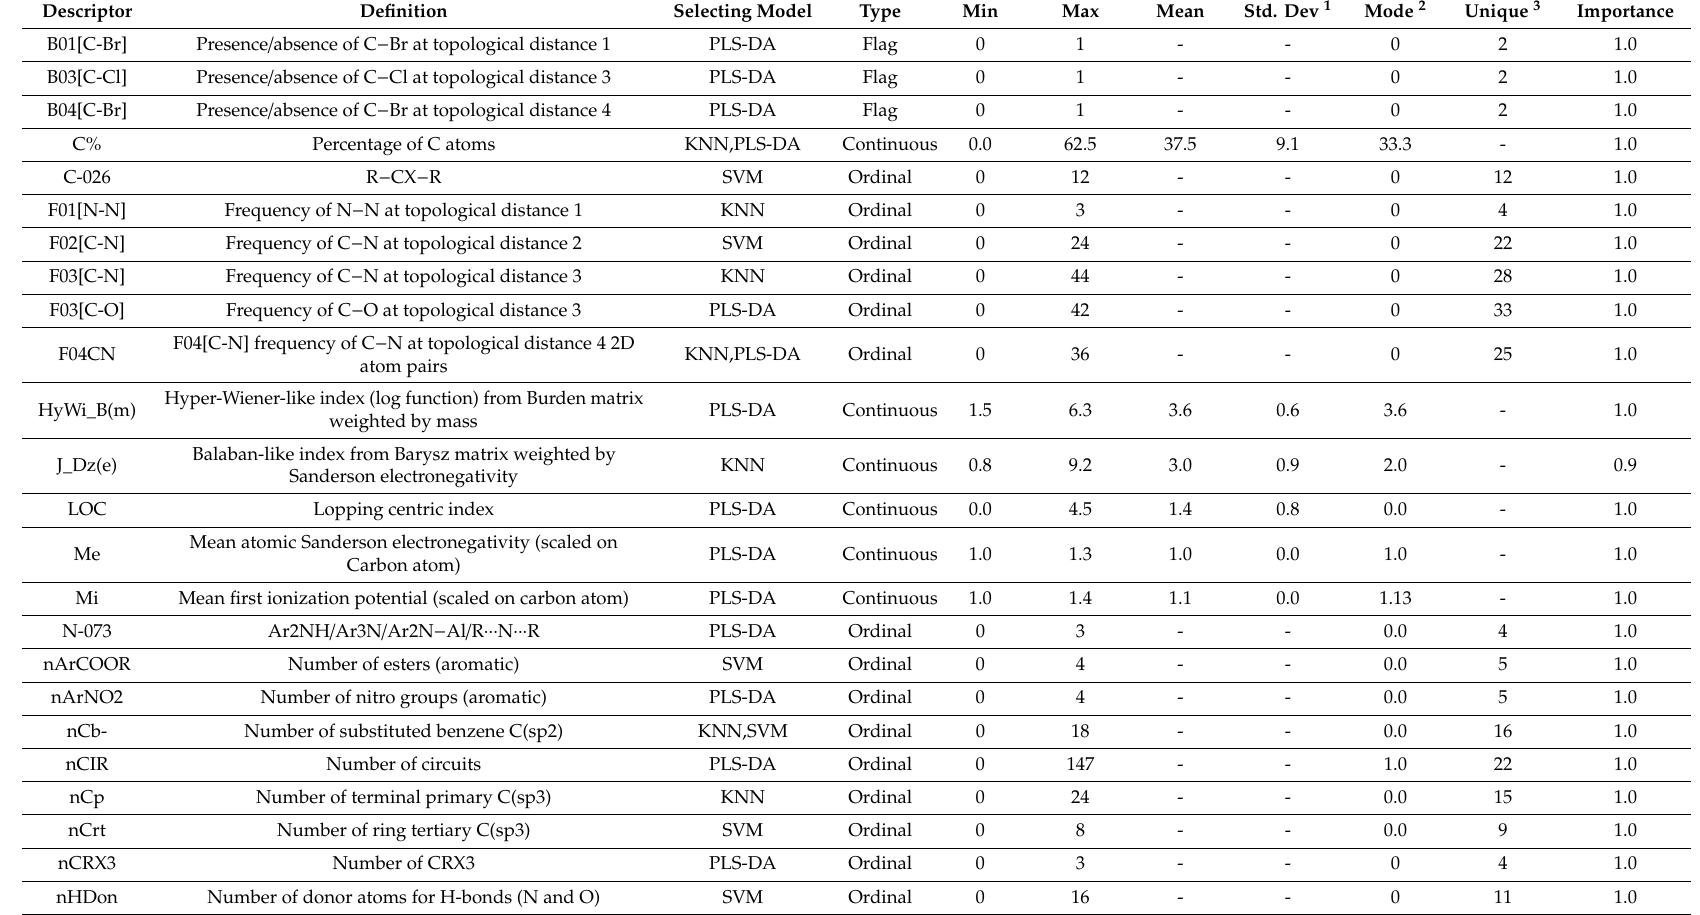
Table 2. Description of the features used for the classification of biodegradable chemicals with their type, minimum, maximum, mean, standard deviation, mode, number of unique values, and predictive